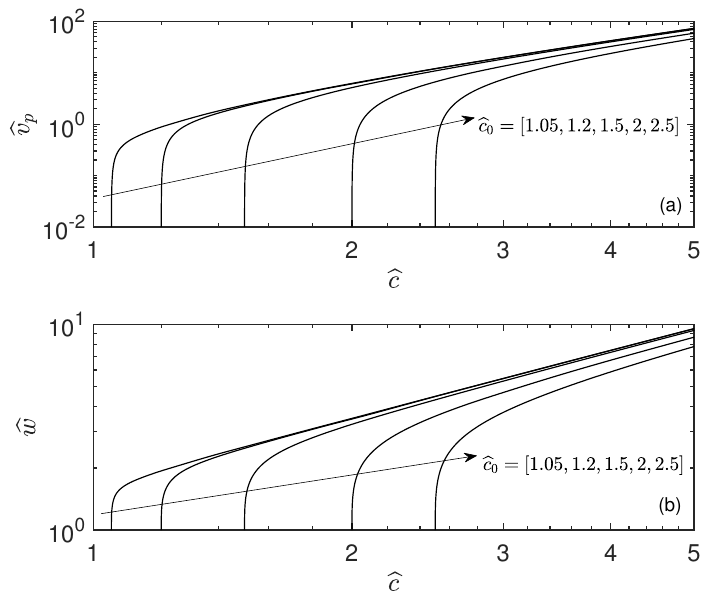
Figure 4. ( a ) Dimensionless peeling velocity and ( b ) corresponding apparent work of adhesion (cid:98) w = w / w 0 for the unloading curves in Figure